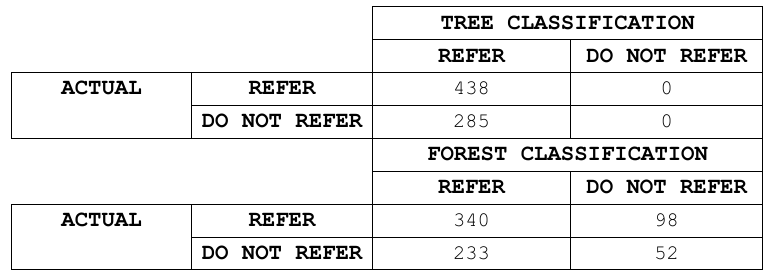
Table 5. One color slope value results.